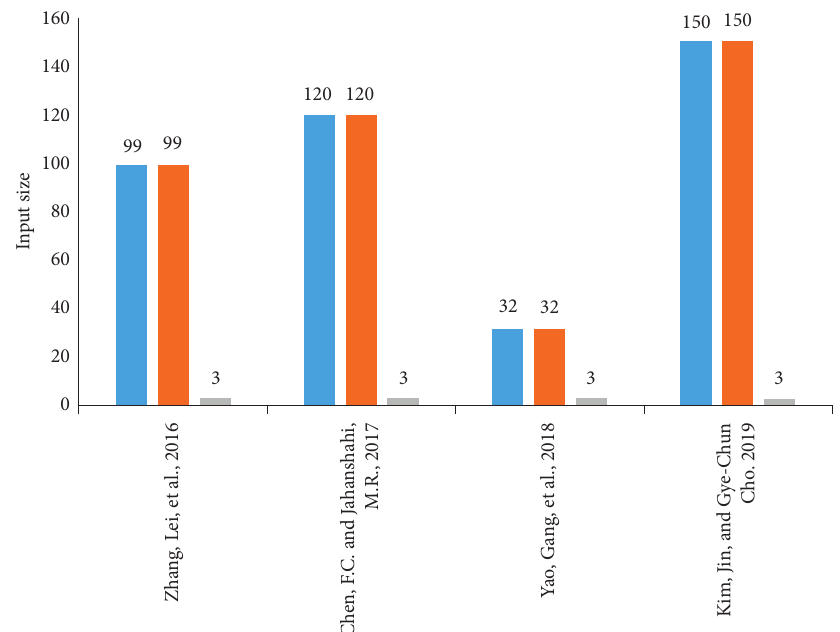
Figure 8: The input size of some studies to monitor infrastructures